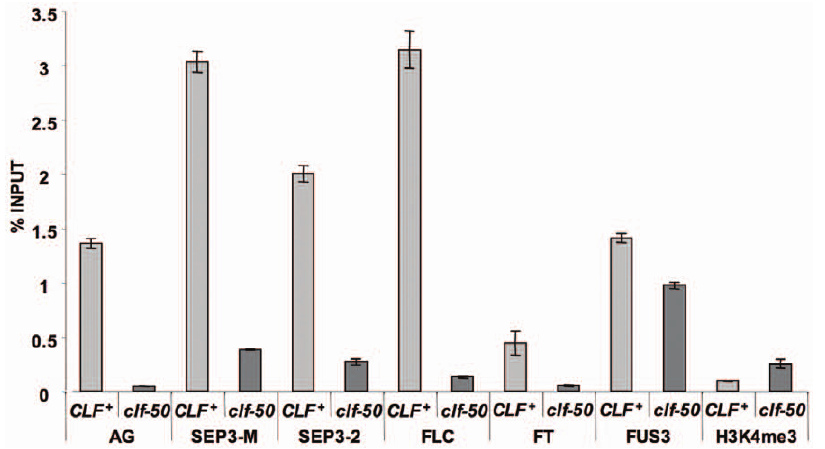
Figure 4. Effect of the clf mutation on histone methylation. ChIP analysis using 12 day old seedlings. Results show H3K27me3 levels at different genes, other than the rightmost bars which show H3K4me3 levels at the AG gene. The SEP3-2 primers amplify a region of the SEP3 promoter previously implicated in regulation of SEP3 by Pc-G proteins [63], SEP3-M amplify part of the large first intron of SEP3 . Error bars are standard error of mean of three technical replicates. The experiment was repeated on independent samples with very similar results as shown in supplementary data Figure S3.